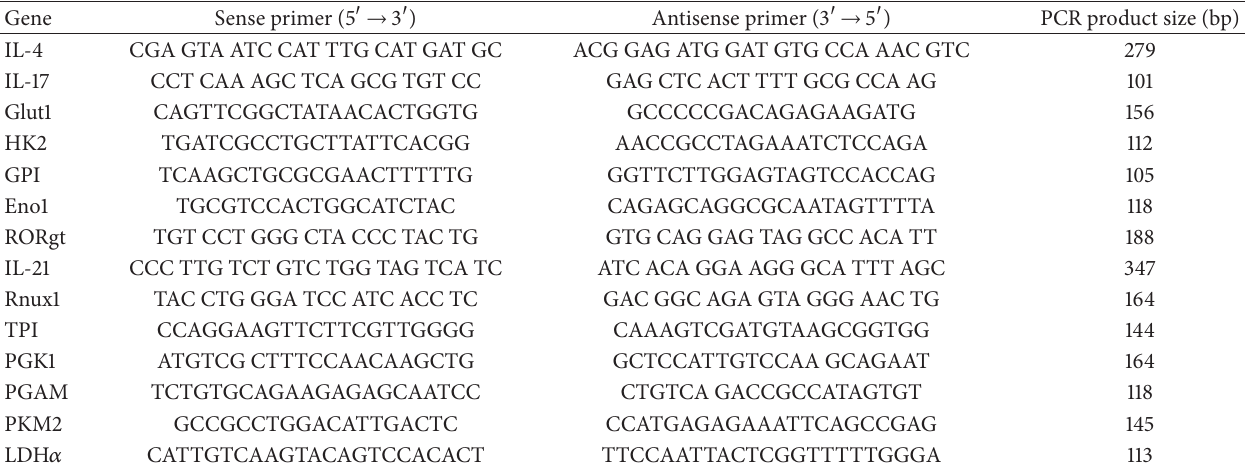
Table 1: PCR primers used in this